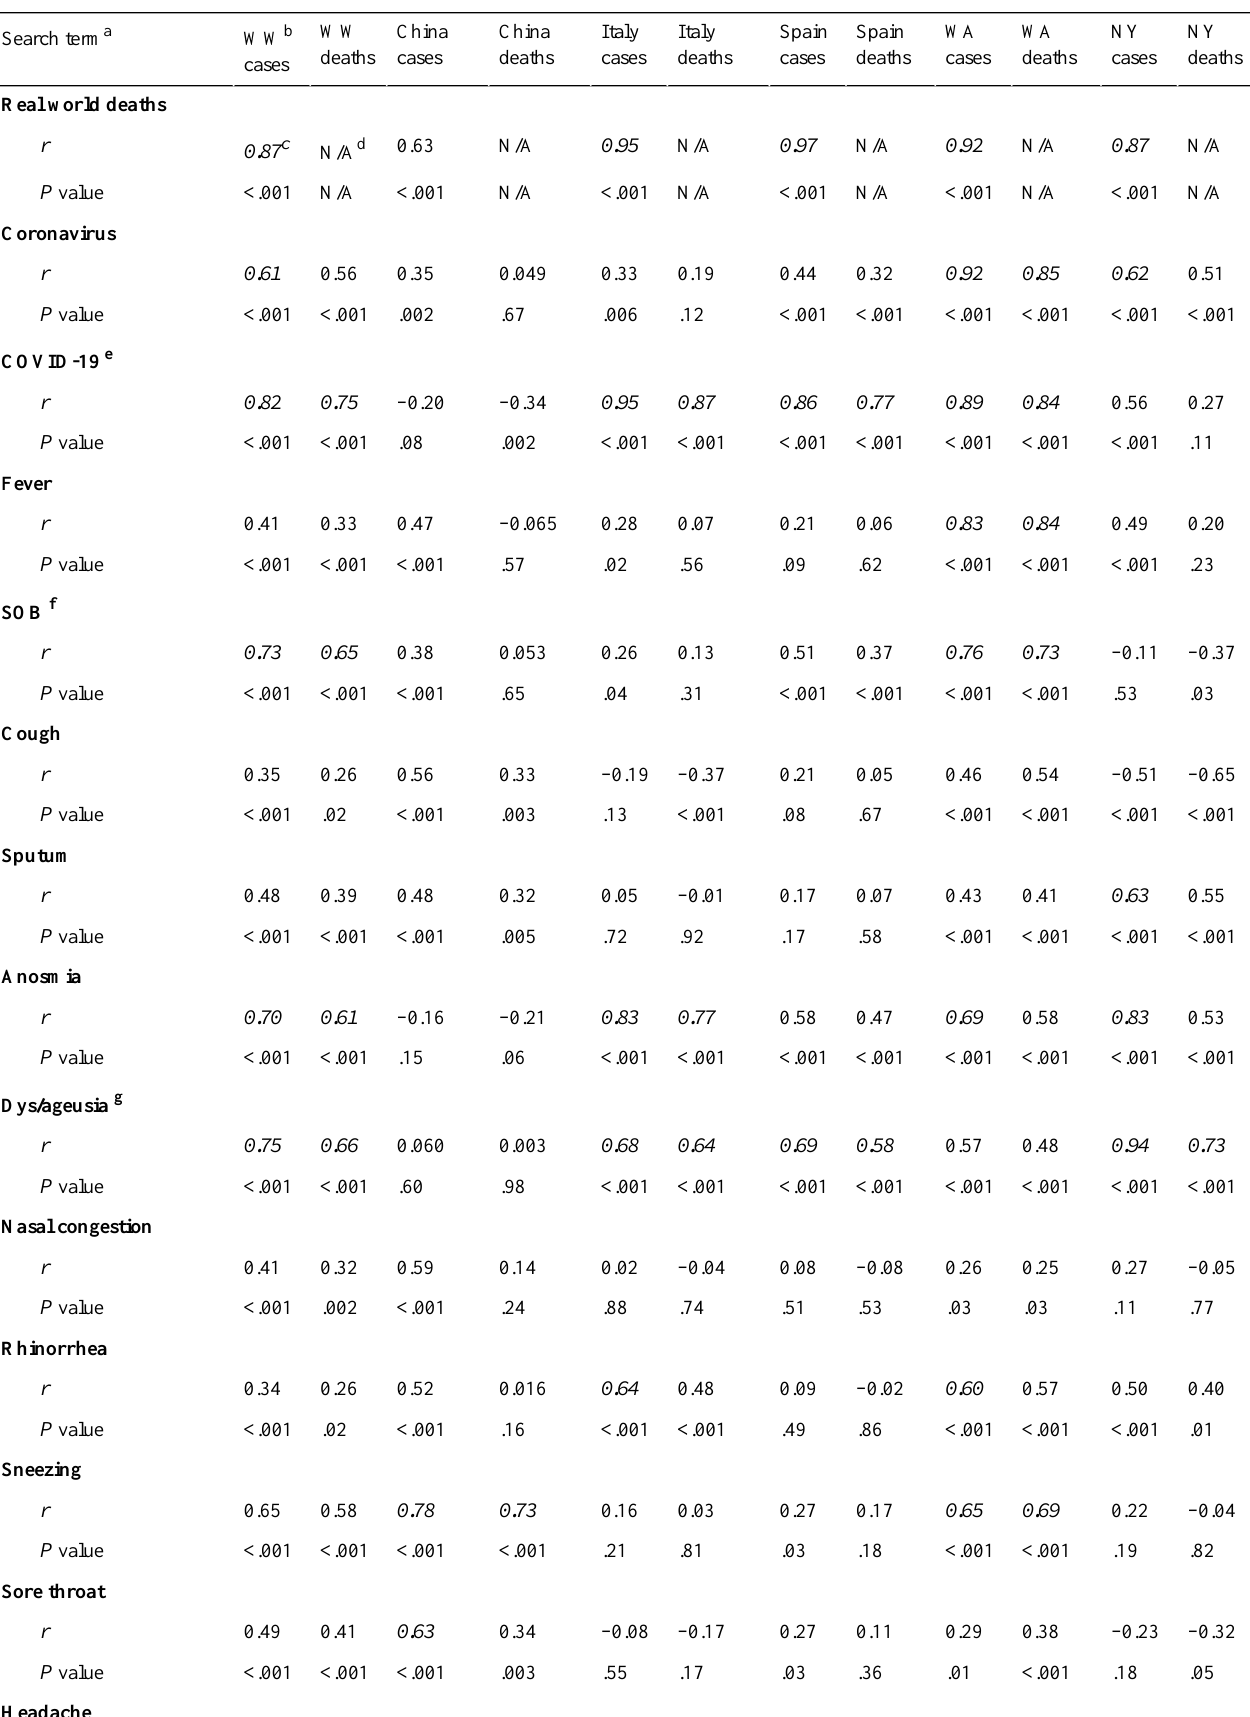
Table 1. Correlations among Google and Baidu search engines and real-world cases and deaths of